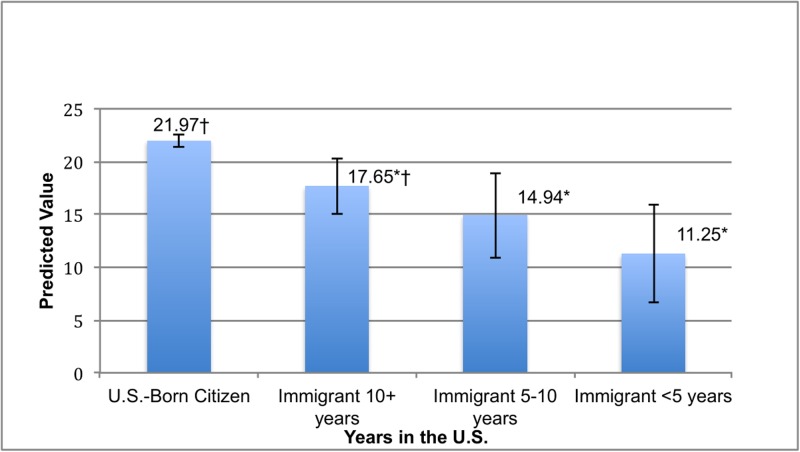
Adjusted rates of emotional difficulty by time in the U.S.Data Source: National Health Interview Survey, 2010–2016. All missing data dropped from the sample. Standard errors were calculated using Taylor Series Linearization. Estimates came from a logistic regression model. Error bars represent the 95% confidence interval, * = significantly different from U.S-Born Citizens (P<0.05), † = significantly different from immigrants living in the U.S>5 years (P<0.05).